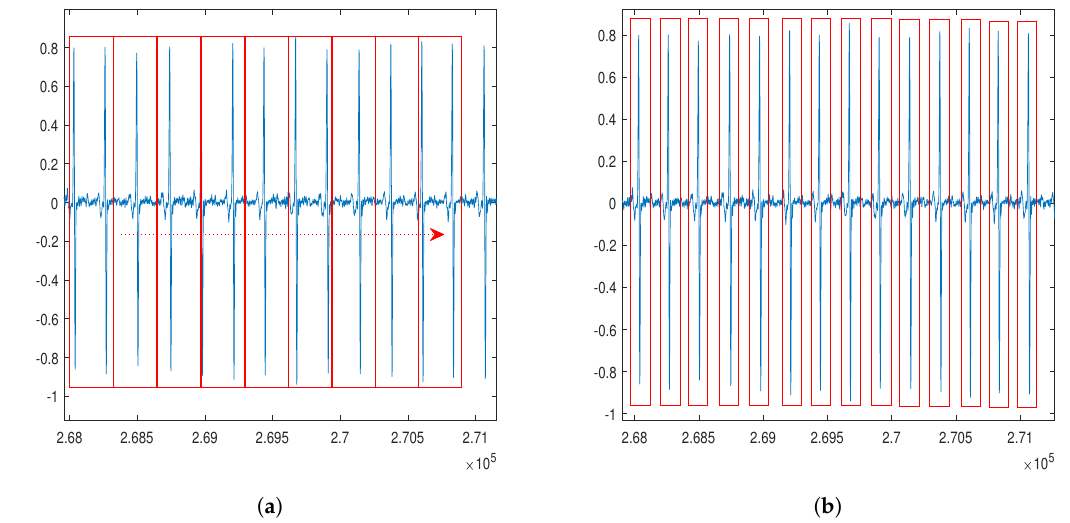
Figure 7. ECG signal segmentation after the normalization: ( a ) a method using a fixed segmentation time period; ( b ) a method using R-peak detection.